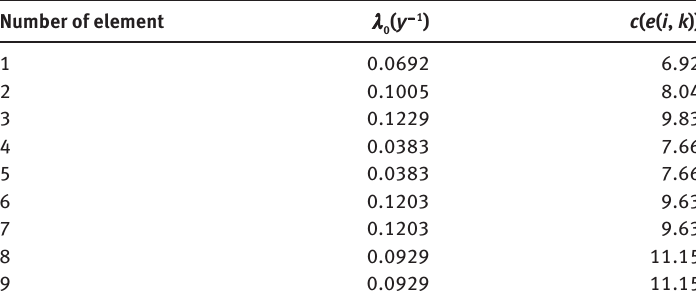
Table 1: Parameters of the Conveyors in the Coal Feeding System. Number of